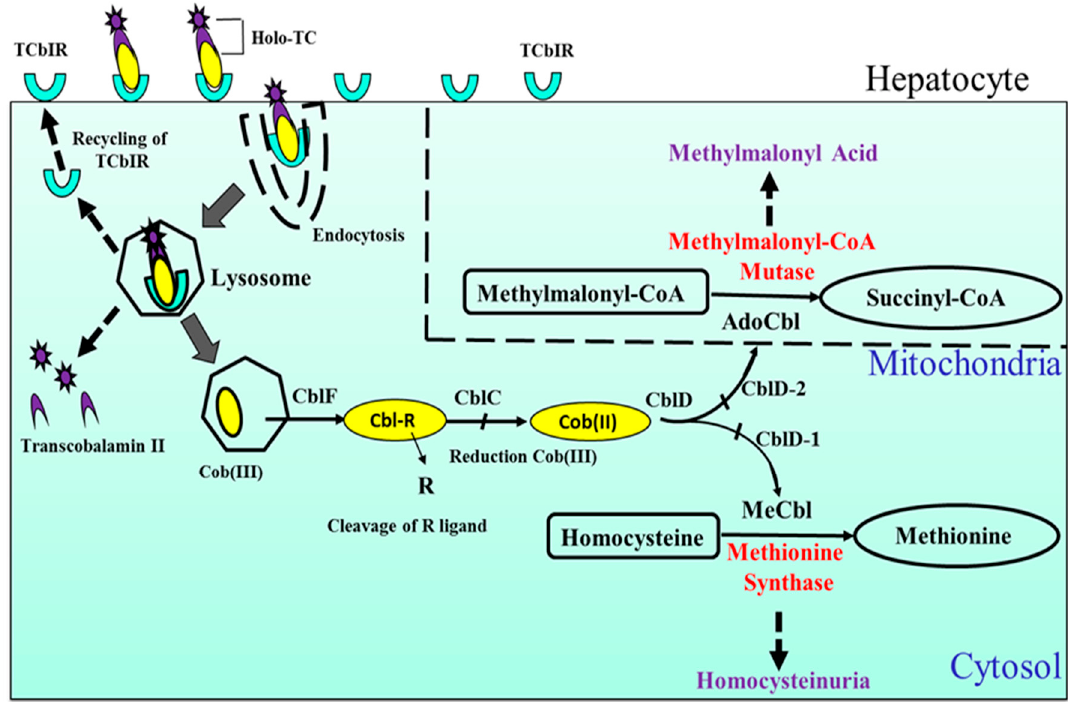
Figure 1. Cellular (hepatocyte) uptake and metabolism of vitamin B12 (B12): Cells generally internalize B12-bound transcobolamin (holo-TC) with the aid of transcobalamin receptor (TCR) TCbIR/CD320 via endocytosis and fused into lysosomes. Within this organelle, B12 is liberated from the TC with the latter (Apo-TC) subjected to degradation whilst the former (B12) is transported to the cytosol and further processed to its catalytic forms, methyl-cobalamin (MeCbl) and 5 ′ -adenosyl cobalamin (AdoCbl), acting in the cytosol and mitochondria as co-enzymes in the methyl malonyl CoA mutase (MCM) and methionine synthase (MS) pathways, respectively. The transcobalamin receptors (TCbIR) are however recycled back to the cellular surface membrane.